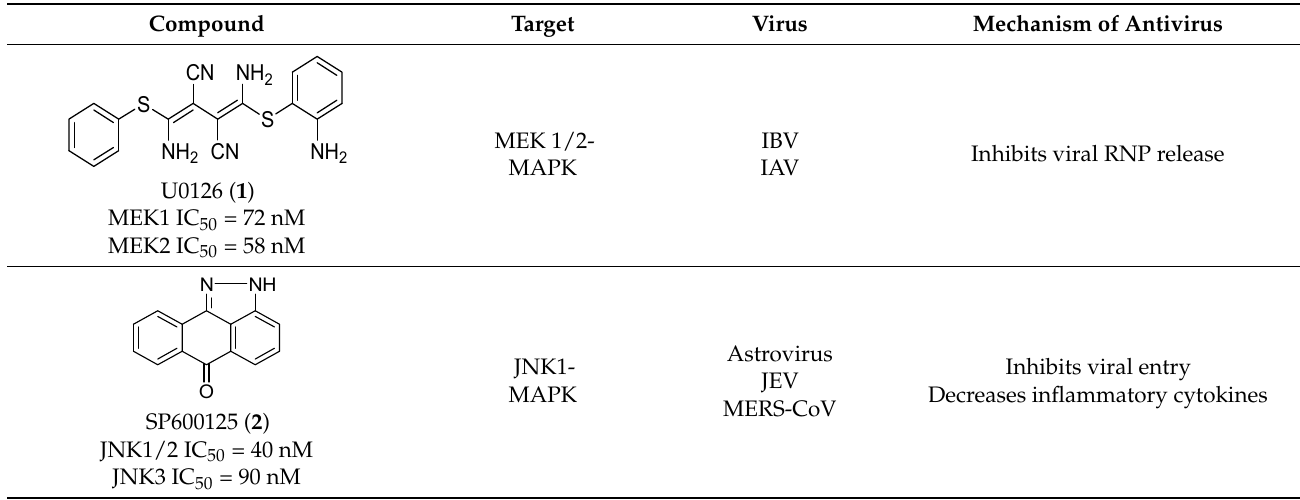
Table 4. Important antiviral kinase inhibitors reported in the biomedical literature.